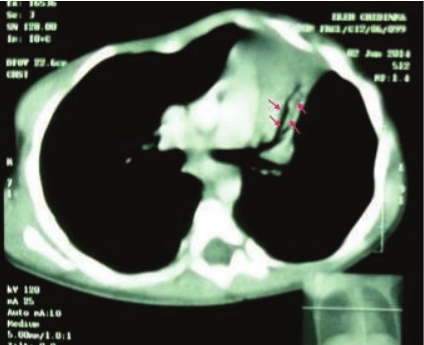
Figure 1: Chest X-ray showing left upper lobe collapse and medi- astinal shift to the ipsilateral side.